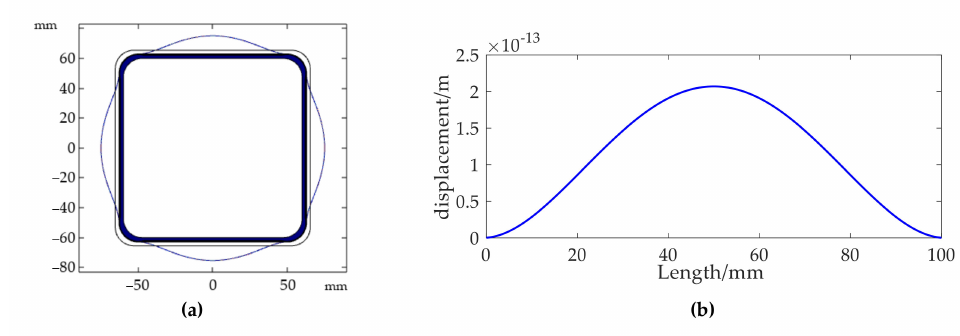
Figure 7. ( a ) Deformation displayed by zoomed-in displacement; ( b ) detailed displacement